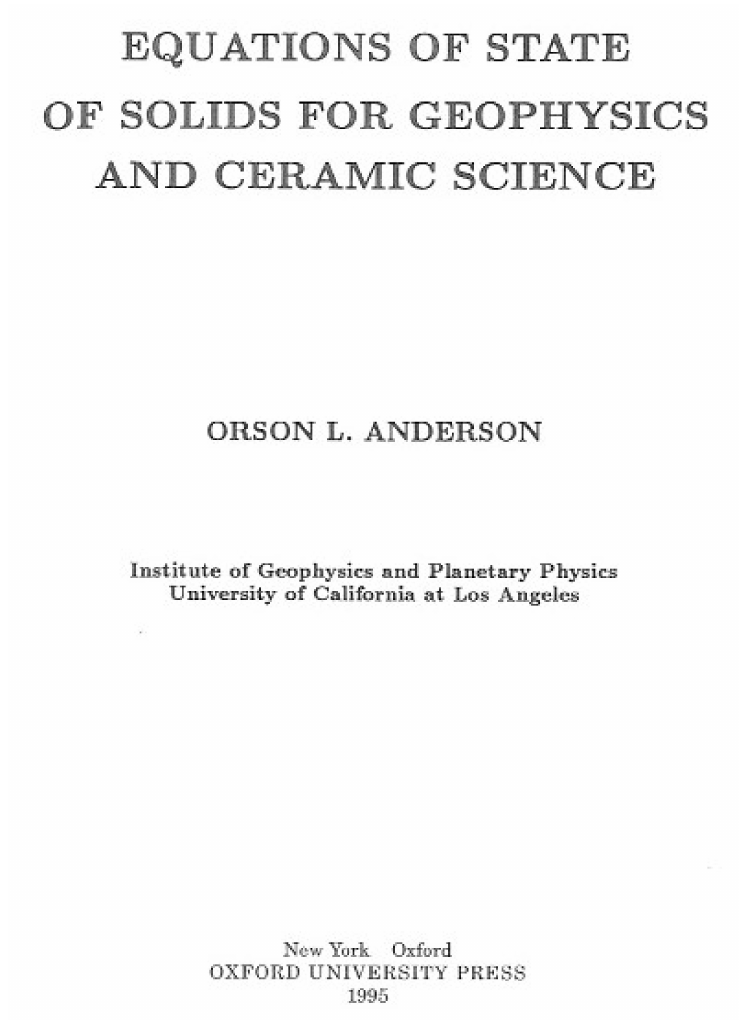
Figure 8. 1995 book by Orson Anderson based on notes for his solid-state geophysics course at Lamont Geological Observatory in the